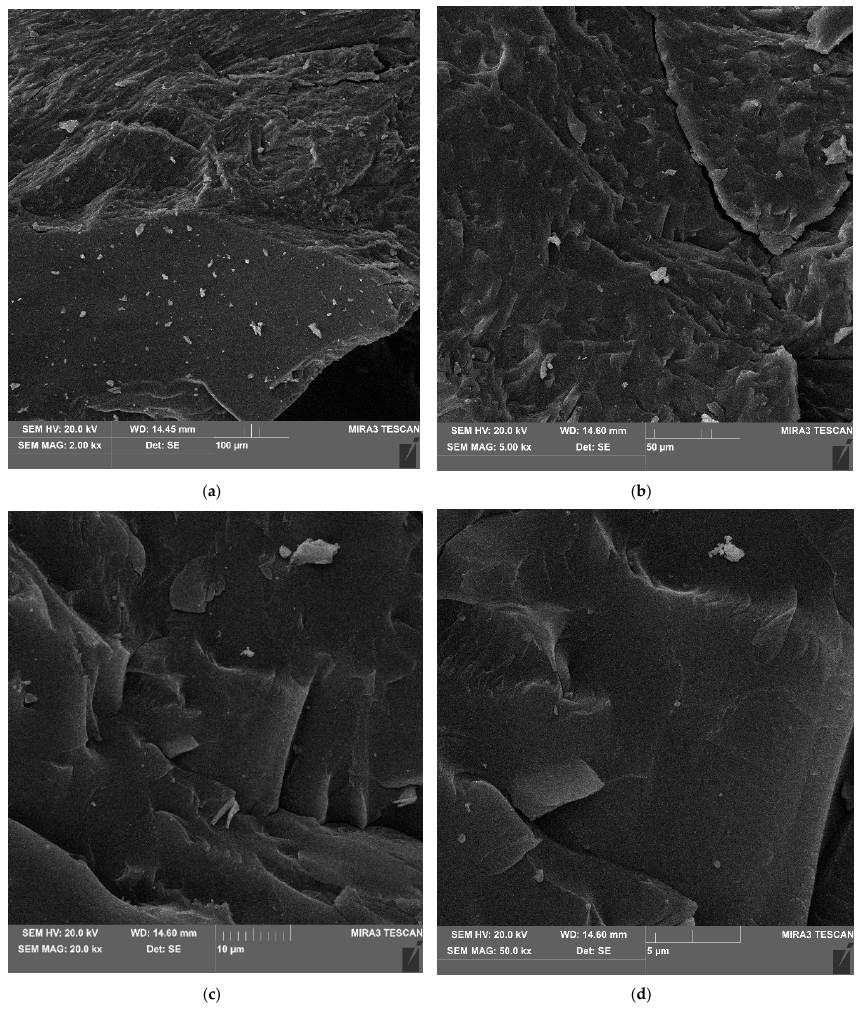
Figure 7. Massive nature of the microstructural surface. SEM imaging at magnification of ( a ) 100 µm; ( b ) 50 µm; ( c ) 10 µm; ( d ) 5 µm.